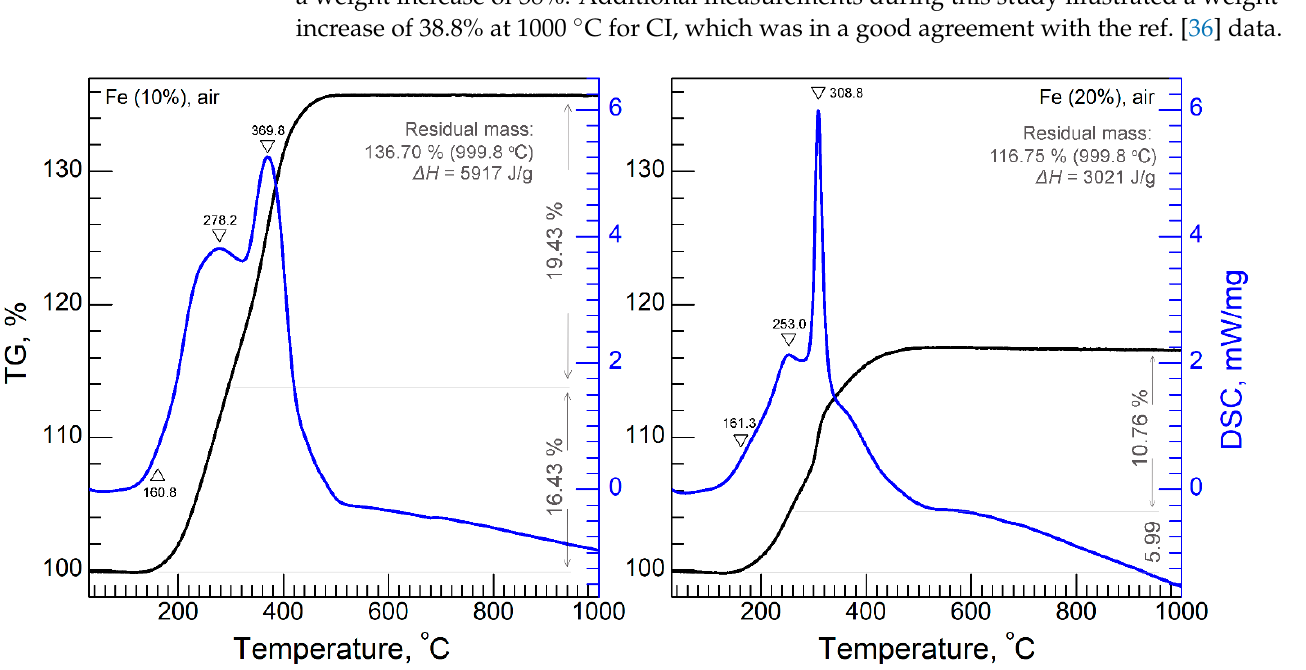
A1a). Insignificant mass loss of 1% was measured for both samples. This was due to